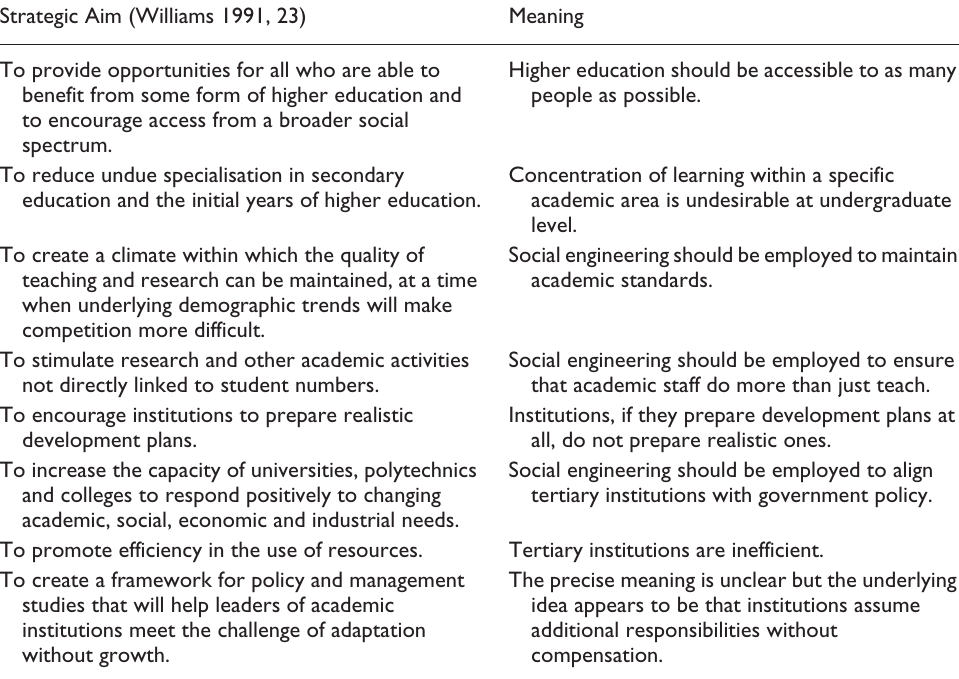
Strategic Aim (Williams 1991,